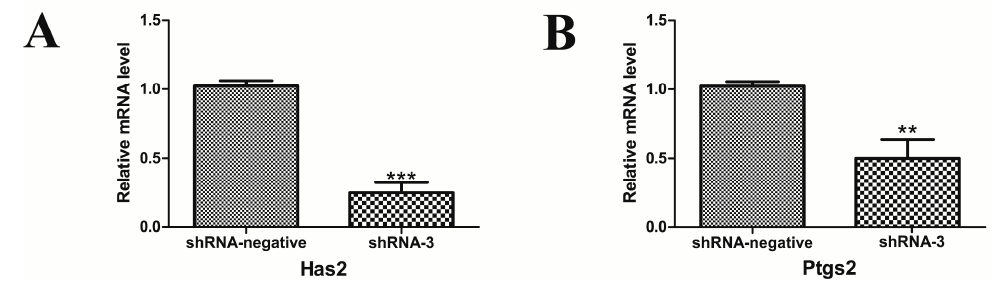
Figure 5. Effects of silent XBP1 on the expression level of genes associated with follicular development and ovulation. ( A , B ) The mRNA expression levels of genes (Has2 and Ptgs2) were determined by real-time PCR in the shRNA-3 group and compared with the shRNA-negative group. Data are shown as the mean ± SEM. Bars with asterisks represent a significant difference (* p < 0.05, ** p < 0.01, *** p < 0.001).